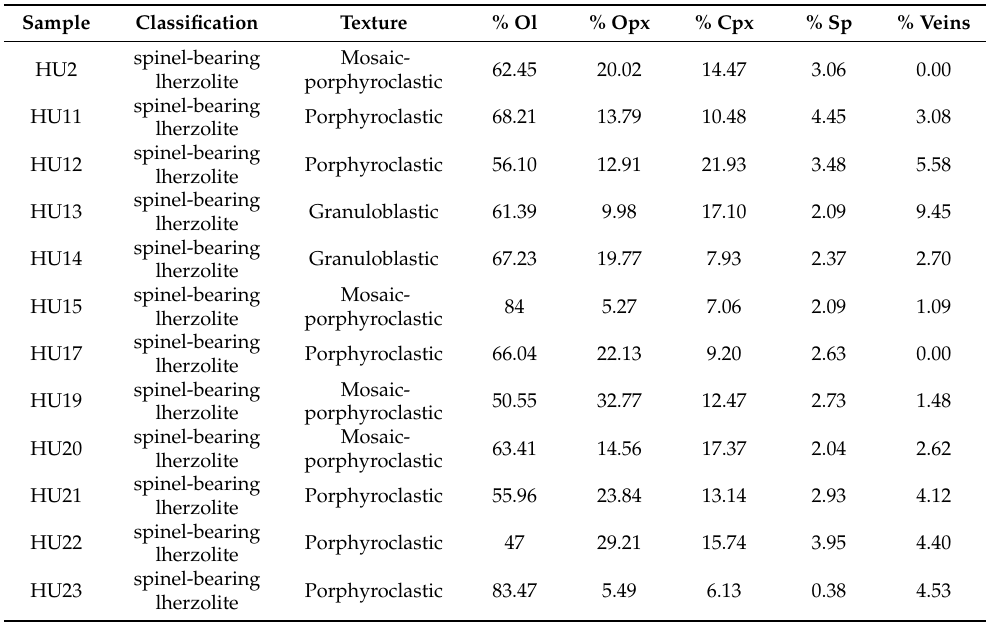
Table 1. Modal compositions of Huanul